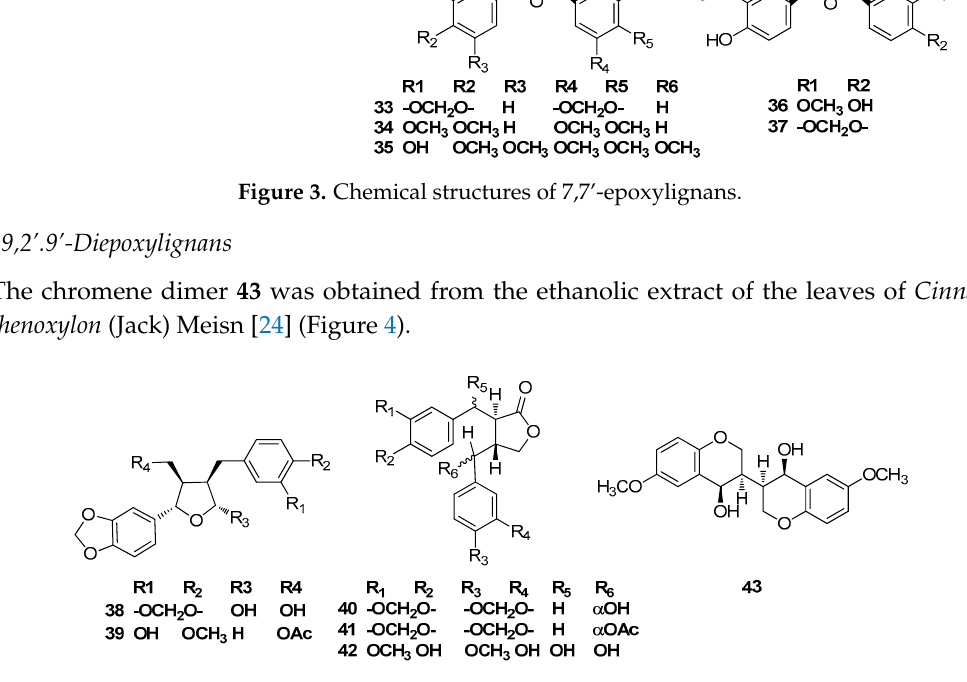
Figure 4. Chemical structures of 7,9’-epoxylignans, lignan-9,9’-olides, and 2.9,2’.9’-diepoxylignans.